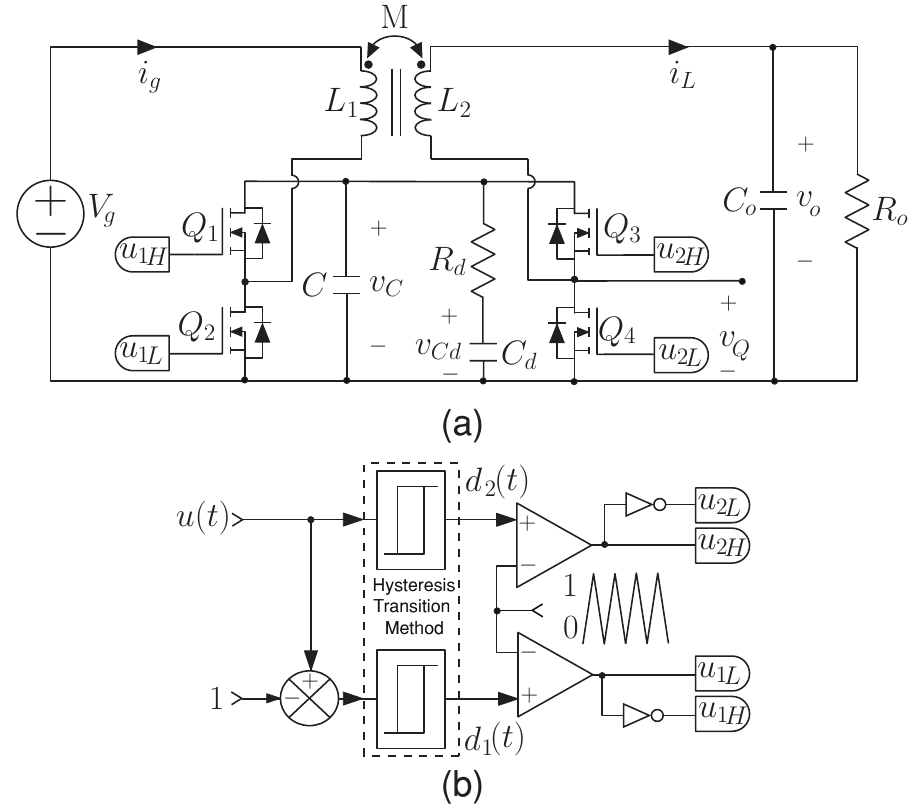
Figure 3. Schemes of ( a ) the buck–boost converter, ( b ) switch signals generation. A novel bidirectional version of the versatile buck–boost converter is presented to extend its use in electric vehicle applications. This new converter shares some similarities with their previous ones (see Figure 4) to preserve all the advantages of the versatile converter. However, two significant changes to match the hard-switching high-voltage bidirectional EV application are included in this new version. The first one corresponds the use of the Silicon Carbide (SiC) devices that extend the operation at high-voltage with low switching losses [23,38–40]. The second one corresponds with a redesign of the coupled inductors to reduce the parasitic winding-to-winding capacitance [41]. Other important aspects that differentiate the converter presented in this work from the existing ones are summarized in Figure